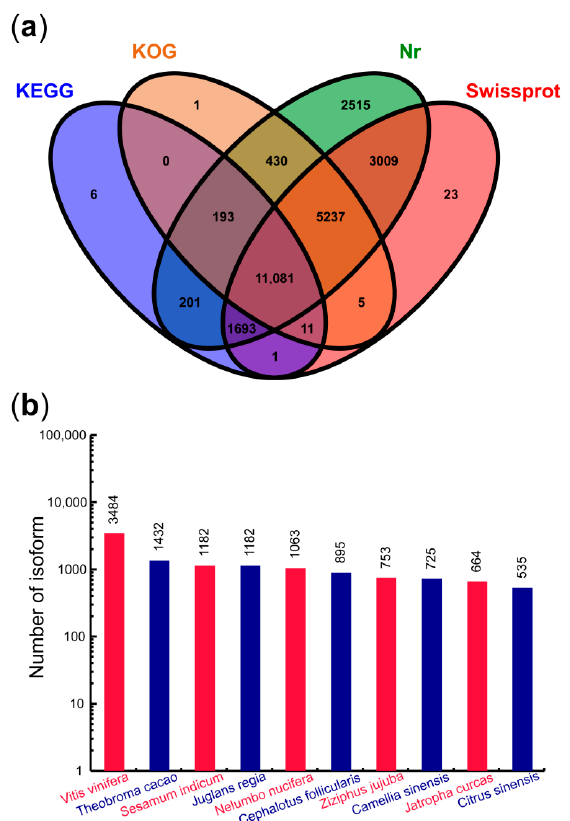
Figure 8. Functional annotation of corrected isoforms. ( a ) Venn diagram of annotated result in four different databases, Nr, Swissprot, KOG, and KEGG. ( b ) Distribution diagram showing the top ten Nr homologous species of transcripts.